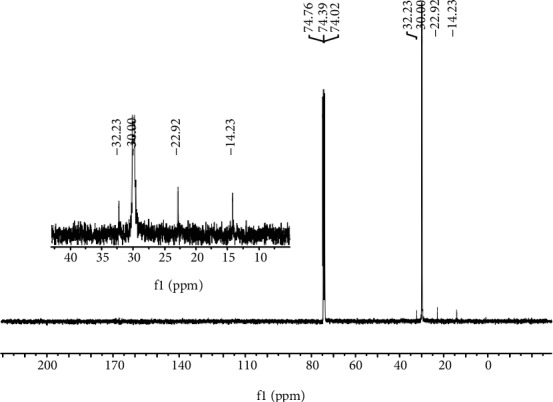

13C NMR spectrum of the polyethylene produced using Fe4/MMAO at 40°C; recorded in C2D2Cl4 at 135°C (run 2, Table 3).